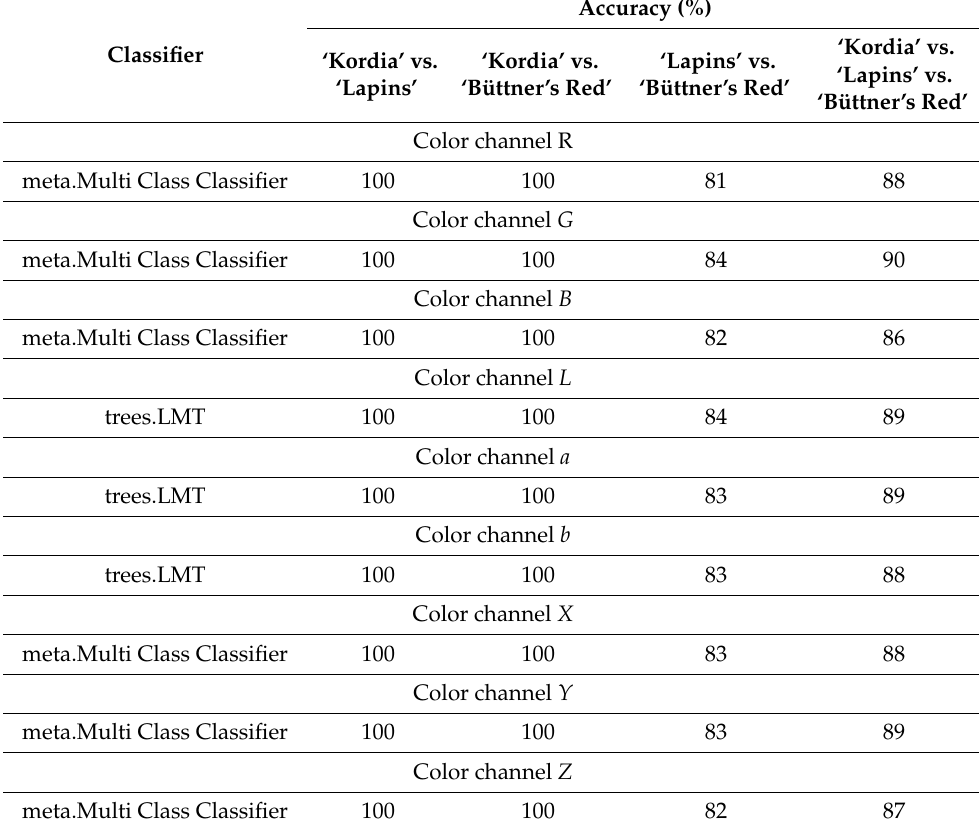
Table 4. The comparison of discrimination accuracies of the endocarp (pit) of different sweet cherry cultivars for separate color channels R, G, and B from RGB color space, color channels L , a , and b from Lab color space, color channels X , Y , and Z from XYZ color space for one the best classifier. Accuracy (%) ‘Kordia’ vs. Classifier ‘Kordia’ vs. ‘Kordia’ vs. ‘Lapins’ vs. ‘Lapins’ vs. ‘Lapins’ ‘Büttner’s Red’ ‘Büttner’s Red’ ‘Büttner’s Red’ Color channel